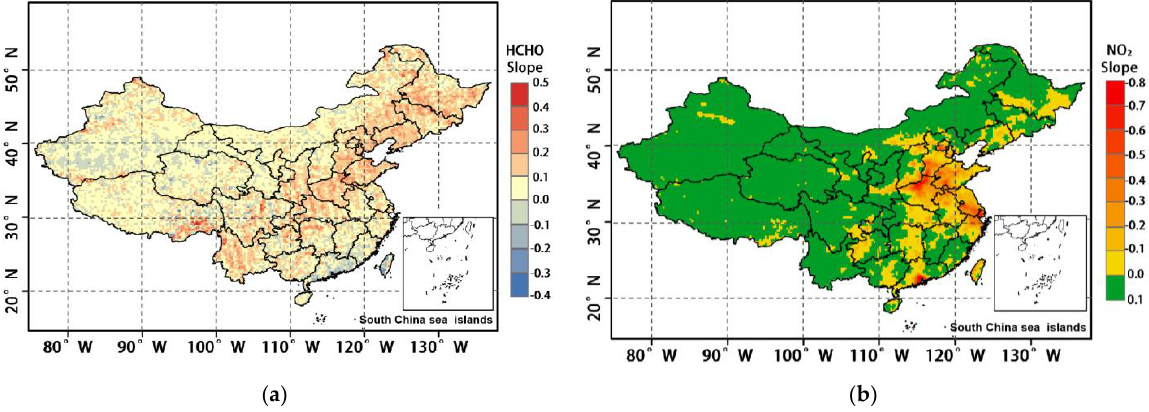
Figure 10. Slope variation trend of ozone precursors: ( a ) slope variation trend of HCHO; ( b ) slope variation trend of HCHO.